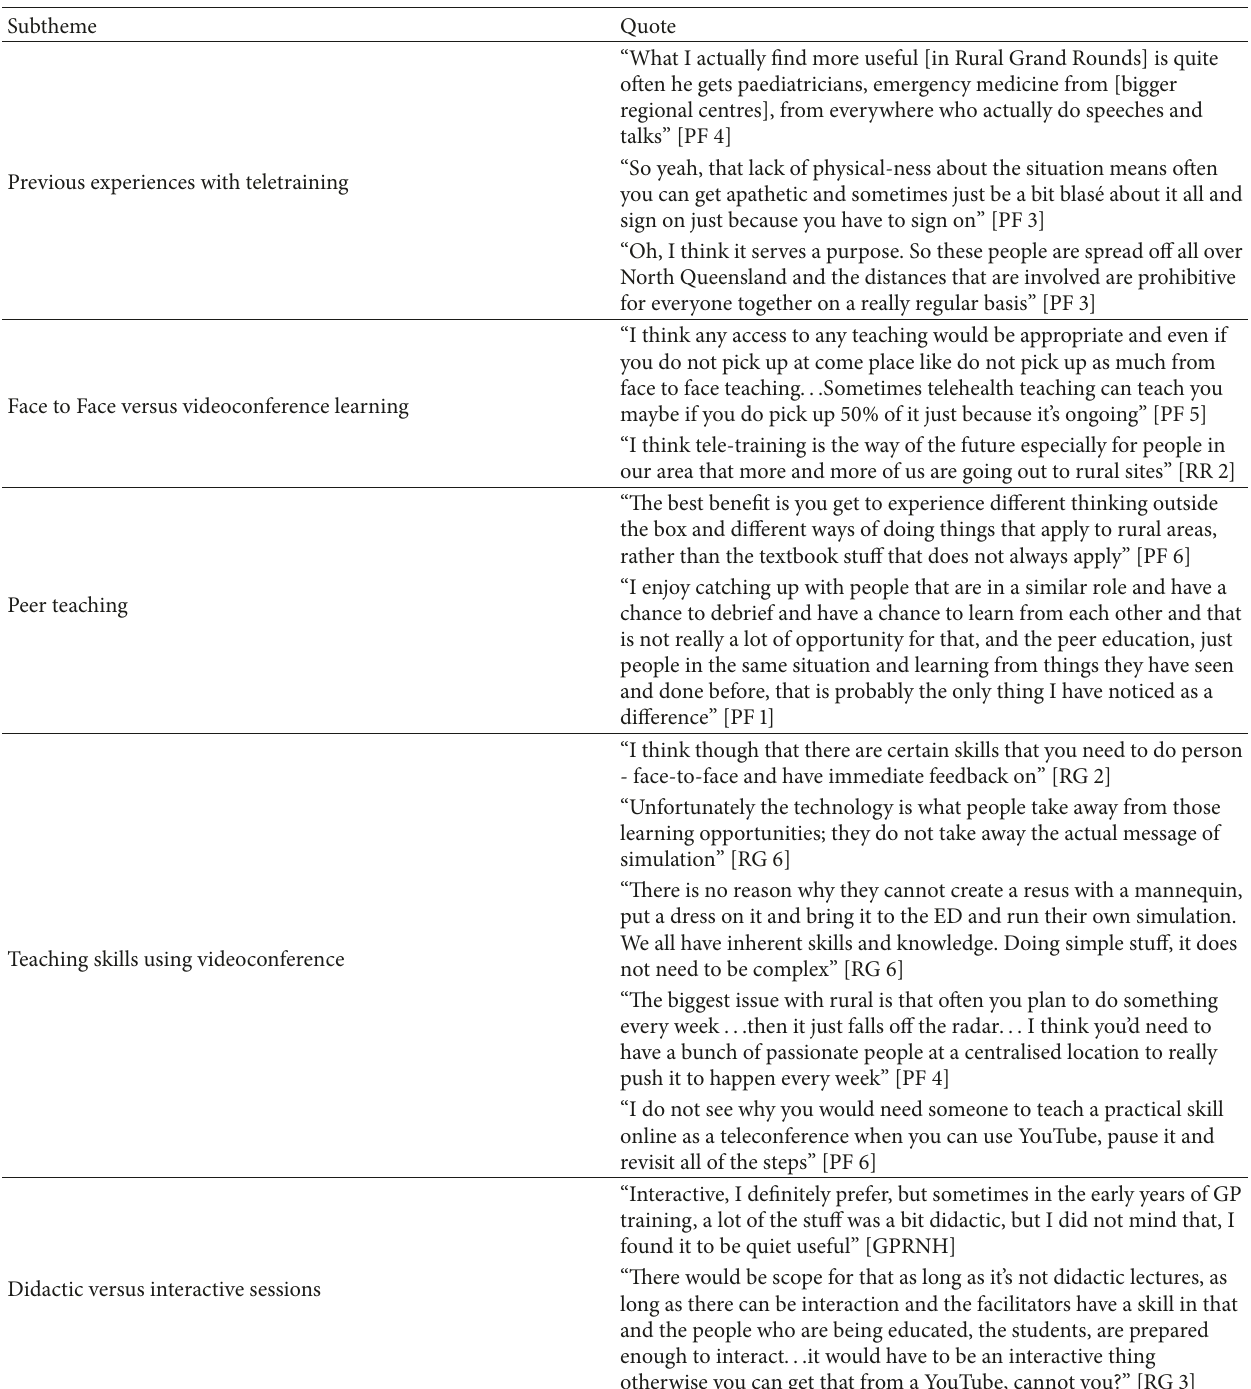
Table 2: Teletraining as